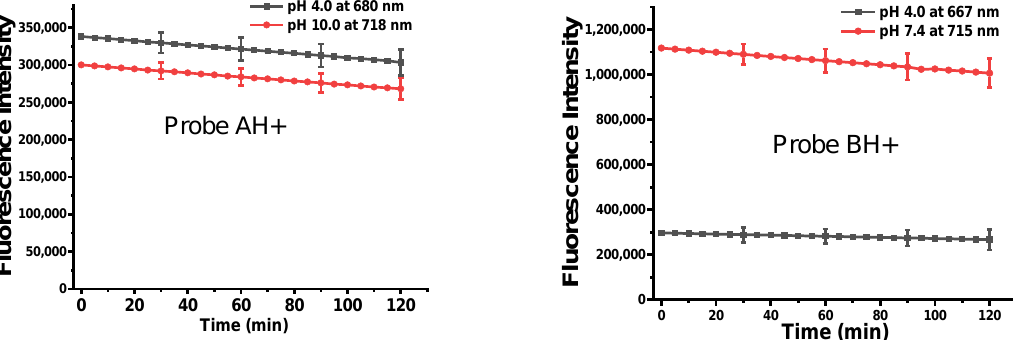
Figure 11. Photostability of 5 μM fluorescent probe AH + and BH + at pH 4.0 and pH 7.4 buffer solutions containing 1.0% ethanol with three-repeated experiments every 30 min under continuous excitation at 635 nm.